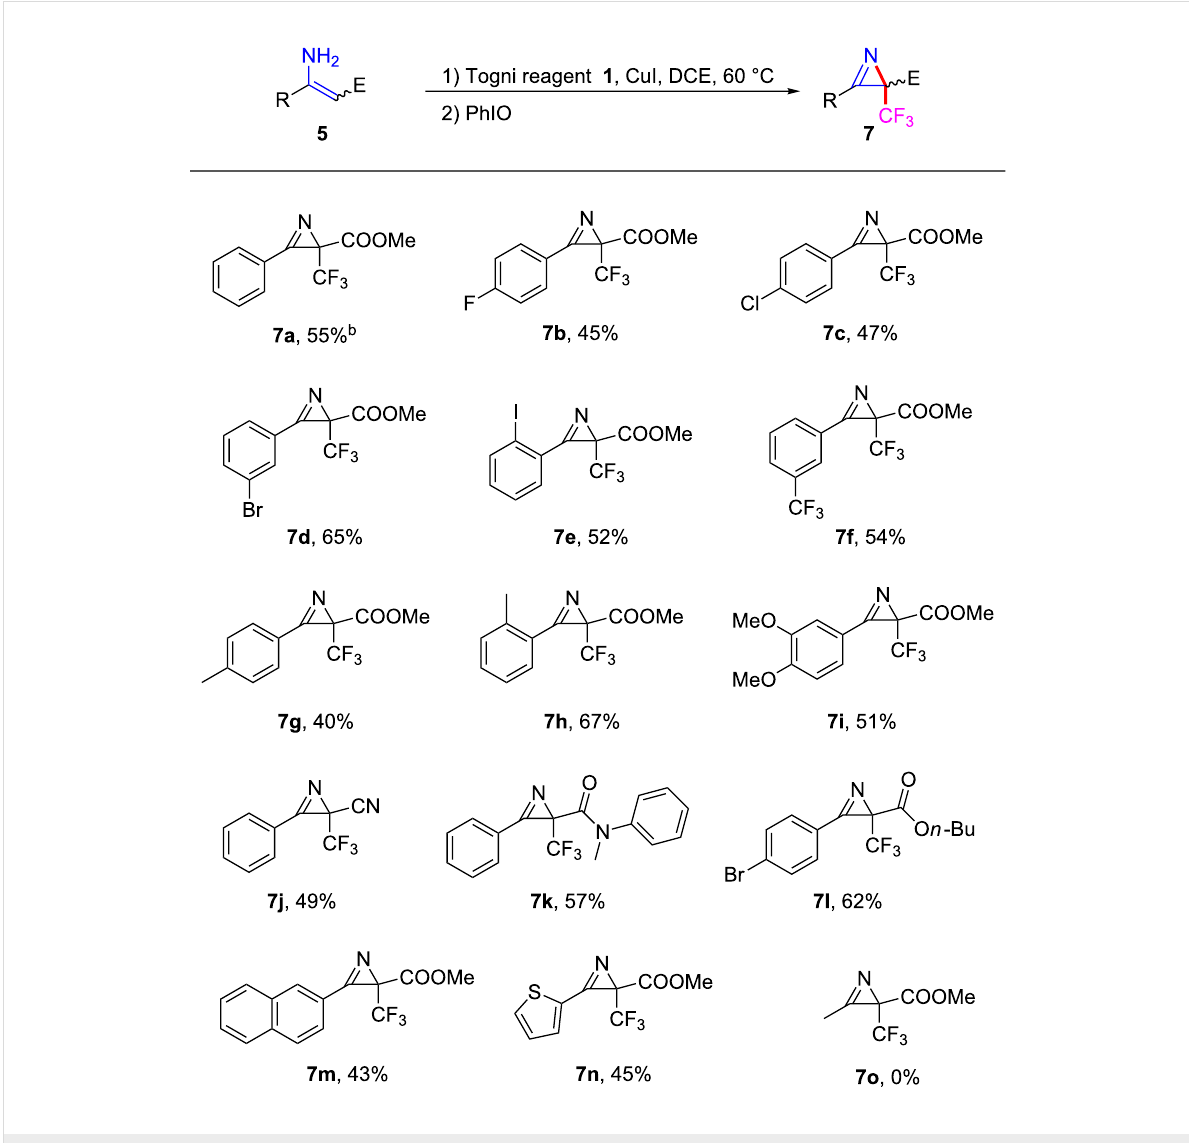
Scheme 3: Togni reagent/PhIO-mediated one-pot synthesis of β -trifluoromethyl 2 H -azirines. Reaction conditions: 1 (1.2 mmol), 5 (1.0 mmol), CuI (0.2 mmol), PhIO (1.5 mmol) in DCE (10 mL) unless otherwise stated. PhIO was added to the reaction mixture after the substrate 5 was completely consumed (TLC analysis). Yields refer to isolated